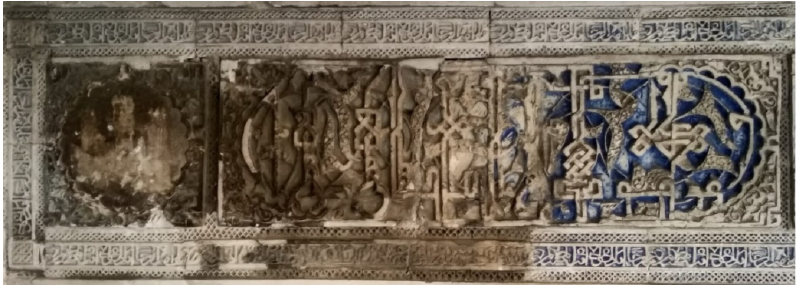
Figure 5. Differences in the degradation level shown in a plaster frieze from the Courtyard of the Maidens (Royal Alcazar of Seville).